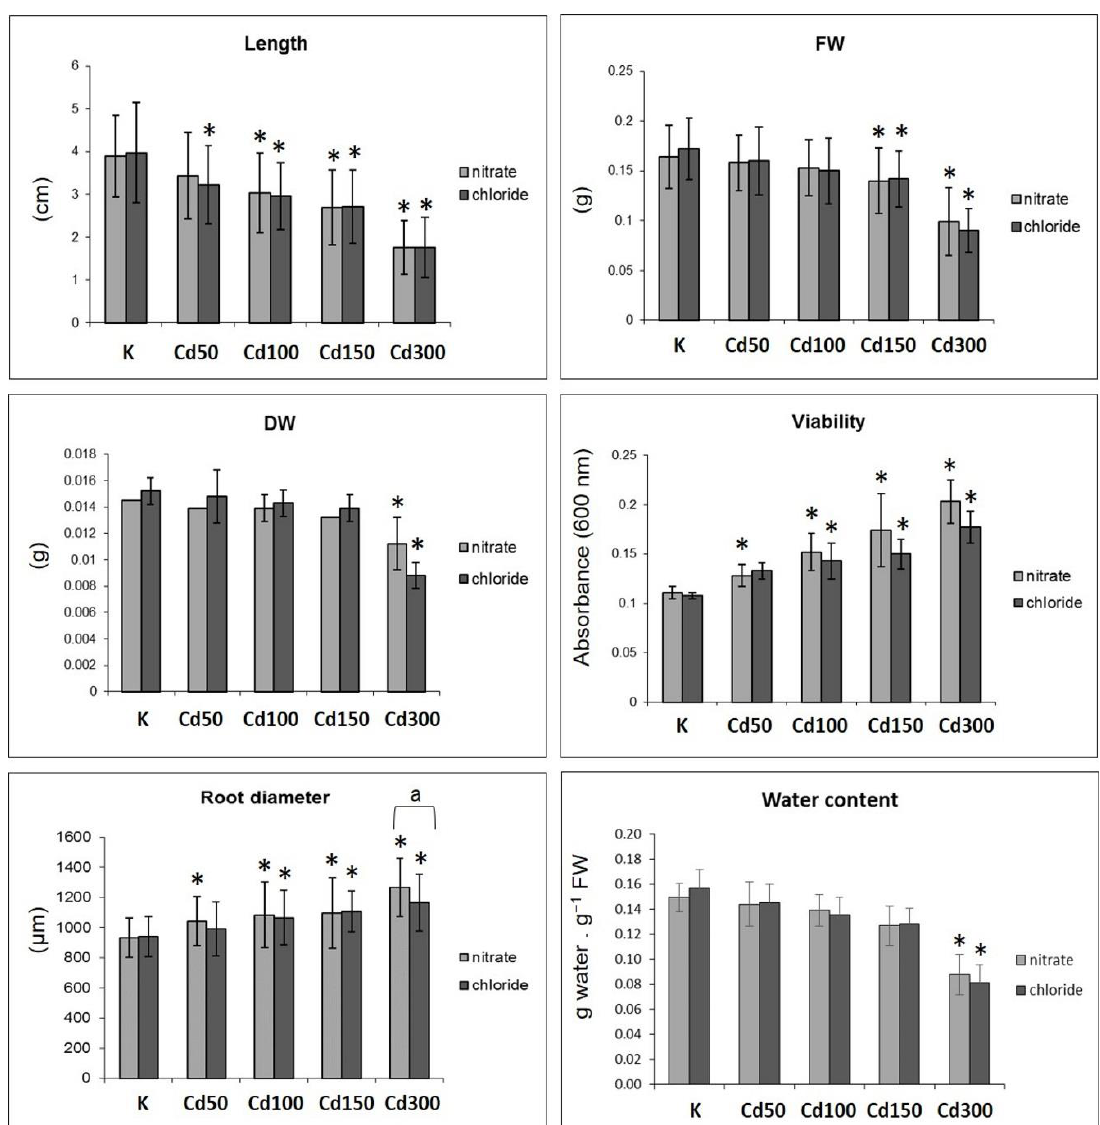
Figure 2. Effects of different doses of cadmium (0–300 mg/L) applied in the form of nitrate or chloride on the growth and physiological parameters of roots of fava bean. The values represent the arithmetic mean ± standard deviation. *—the level of significance of the differences against the control (0 mg/L Cd) at p < 0.05, a—statistically significant differences between the variants of the experiment (nitrate and chloride) at p < 0.05. FW—fresh weight, DW—dry weight.